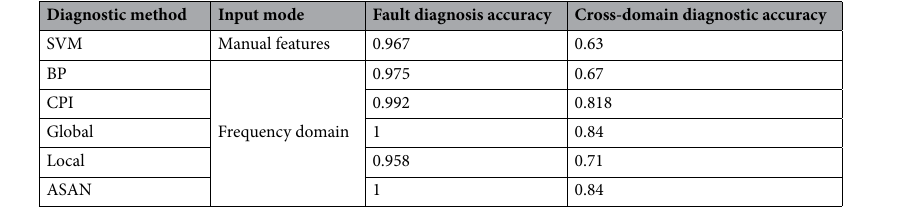
Table 5. Diagnostic performance of different